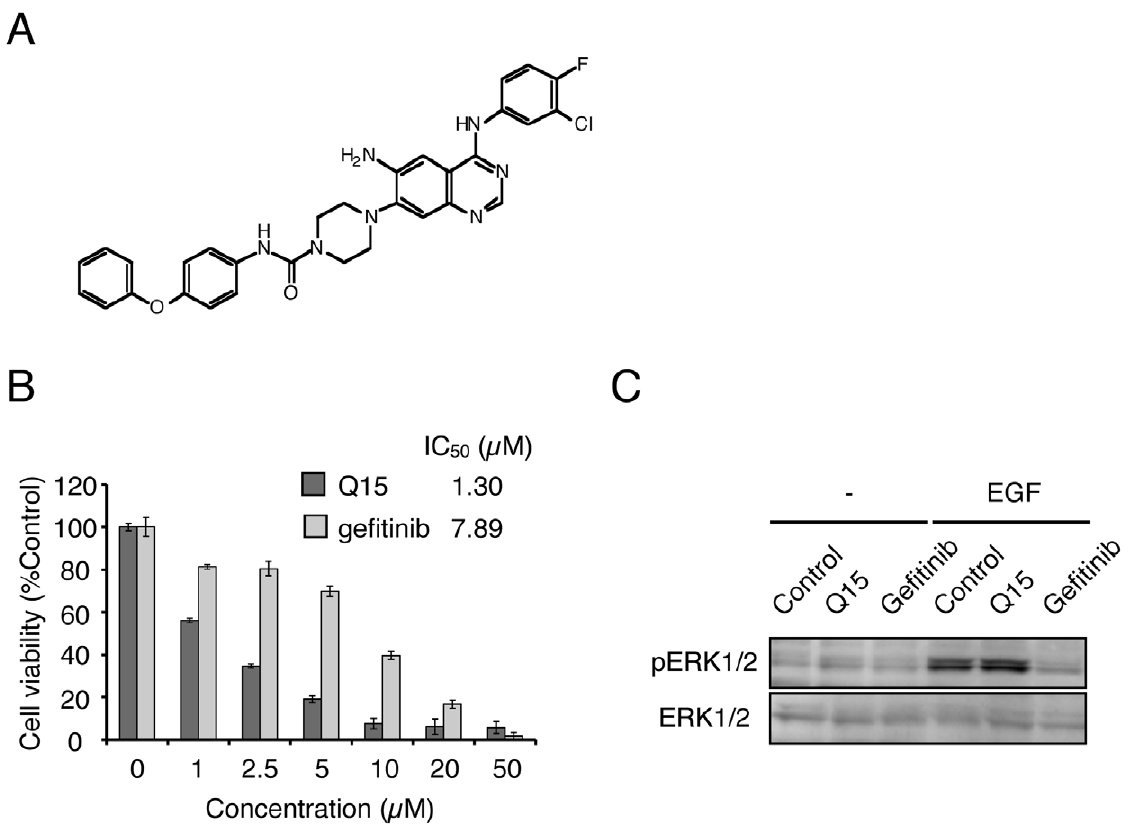
Figure 1. Q15 inhibits proliferation of tumor cells through a different mechanism from that of gefitinib. (A) Chemical structure of Q15. (B) KMS34 cells were incubated with 0–50 m M Q15 or gefitnib for 72 h. Then, cell viability was determined by means of MTS assay. (C) A549 cells were incubated with DMSO or 5 m M Q15 for 24 h in the absence or presence of 50 ng/mL EGF for 48 h. Whole cell lysates were analyzed by Western blotting with anti-pERK1/2 or anti-ERK1/2 antibody.